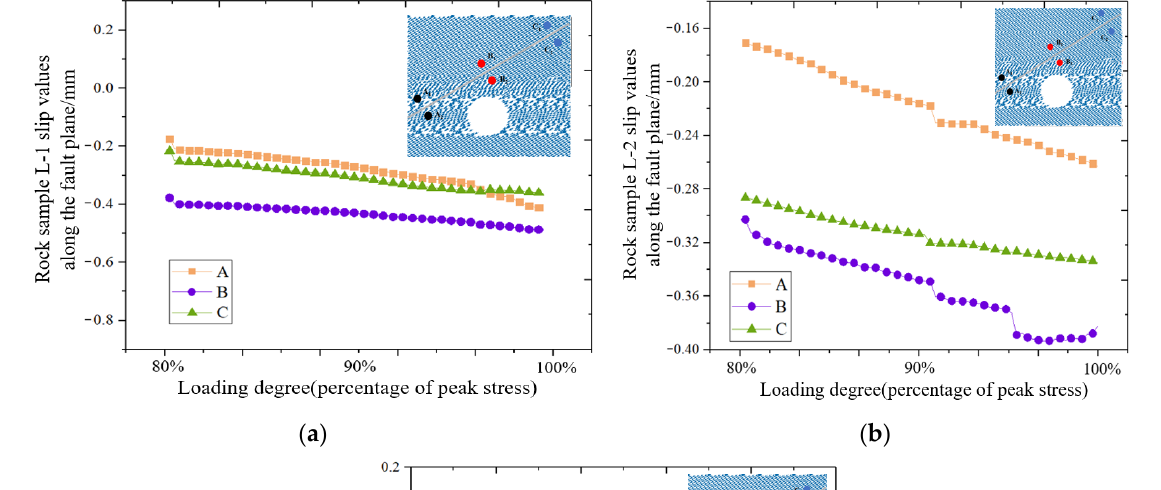
Figure 10. Schematic diagram of the relationship between fracture slip at measurement points and loading degree in group A. ( a ) sample A ‐ 0 slip values; ( b ) sample A ‐ 15 slip values; ( c ) sample A ‐ 30 slip values; ( d ) sample A ‐ 45 slip values.